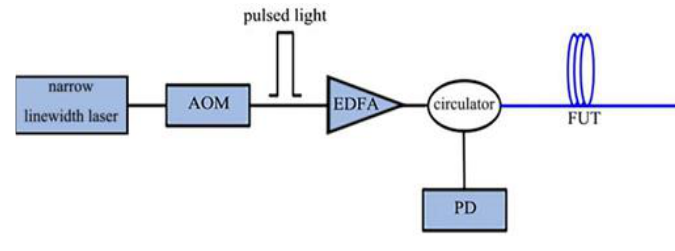
Figure 3. Ф -OTDR structure diagram. Figure 3. Φ -OTDR structure